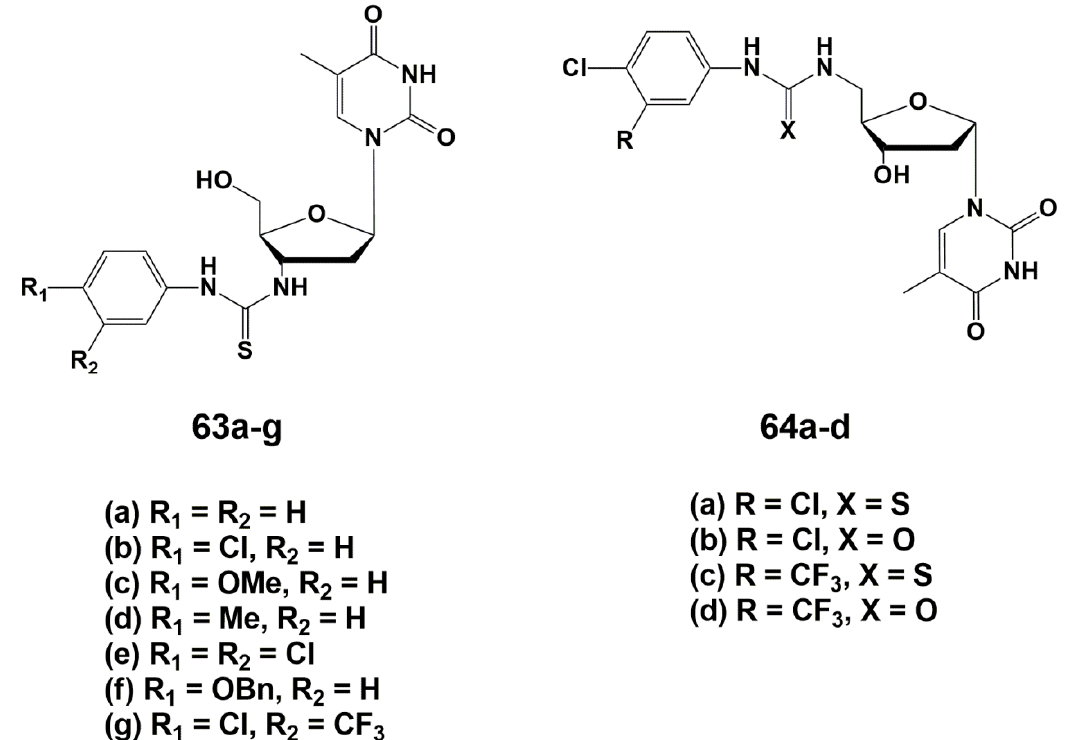
Figure 15. Arylurea- и arylthiourea- α - and β -thymidine derivatives 63a – g and 64a – d .